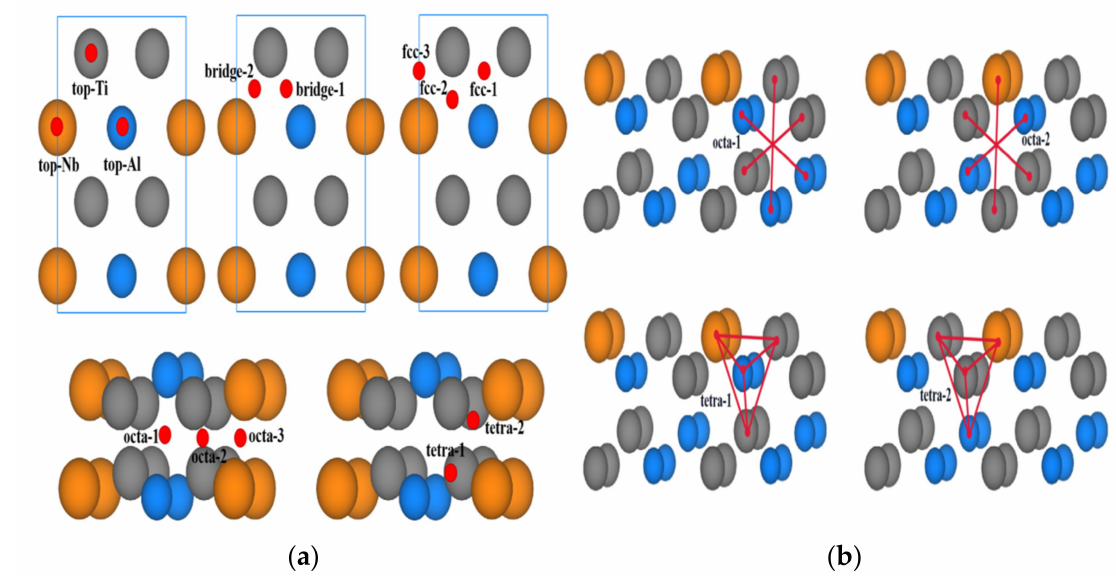
Figure 1. Schematic of the adsorption sites of the Ti 2 AlNb alloy ( a ) On the (010) surface and inside the bulk (top views), ( b ) Interstitial sites at the O(110)/B2(211) interface (side views), red, blue, orange, and gray balls denote O, Al, Nb, and Ti atoms,